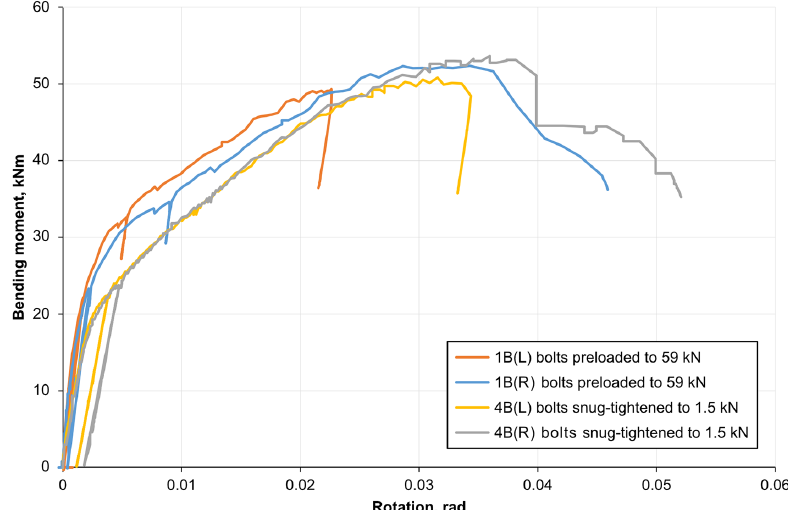
Figure 13. Moment rotation curves